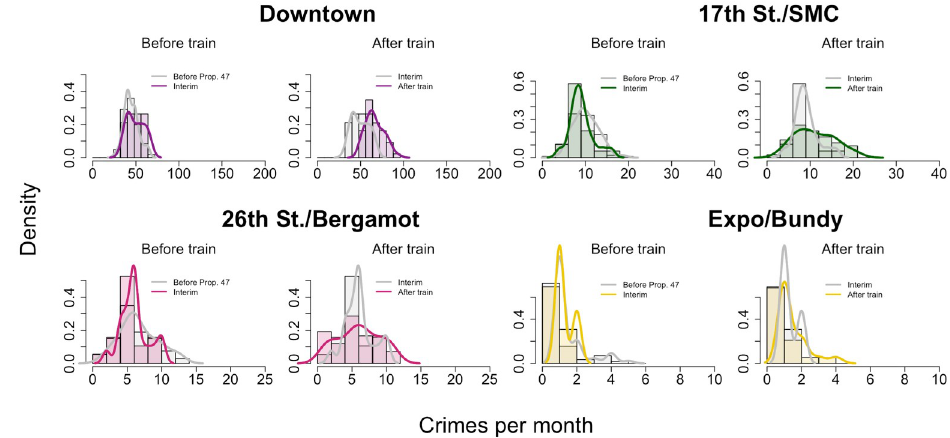
Fig 14. Reported non-Prop. 47 crime near Expo Line light rail stations in Santa Monica, CA, during three successive time periods spanning 2006–2019. This figure is analogous to Fig 12, but restricted to non-Prop. 47 crimes only. See Table 6 for statistical test results.